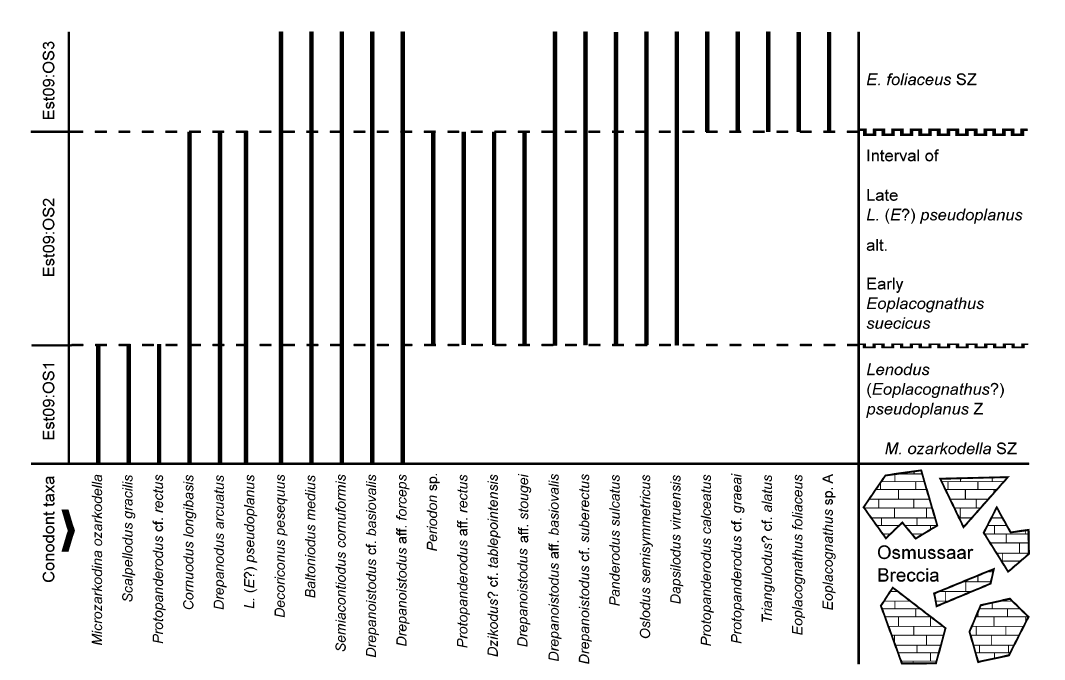
Fig. 4. Stratigraphical ranges of the conodont taxa recorded in the three intervals sampled; see Fig.